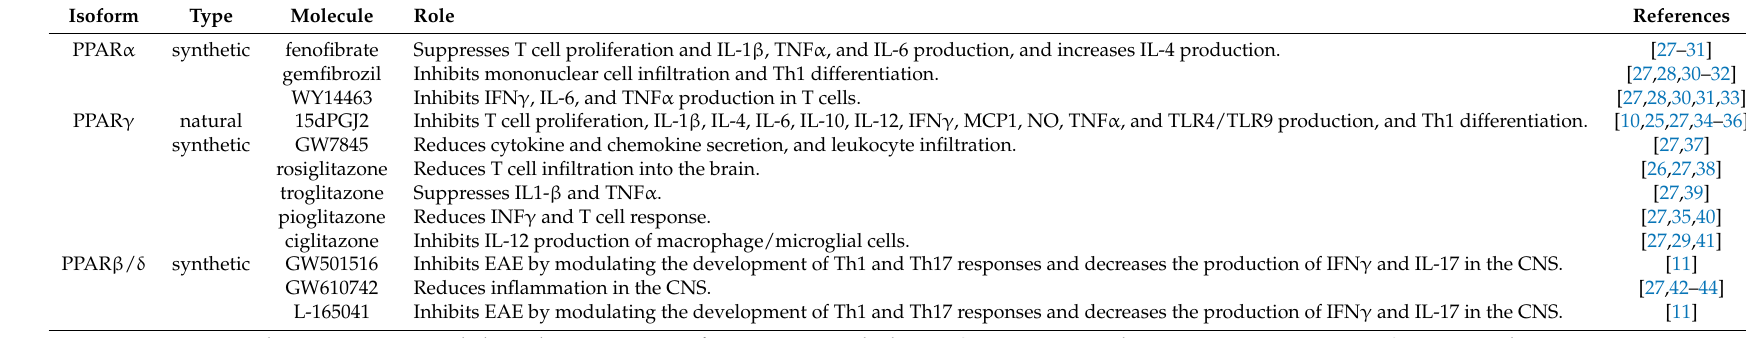
Table 1. Selected agonists of the different peroxisome proliferator-activated receptor (PPAR) isoforms and their implications in immunomodulation.